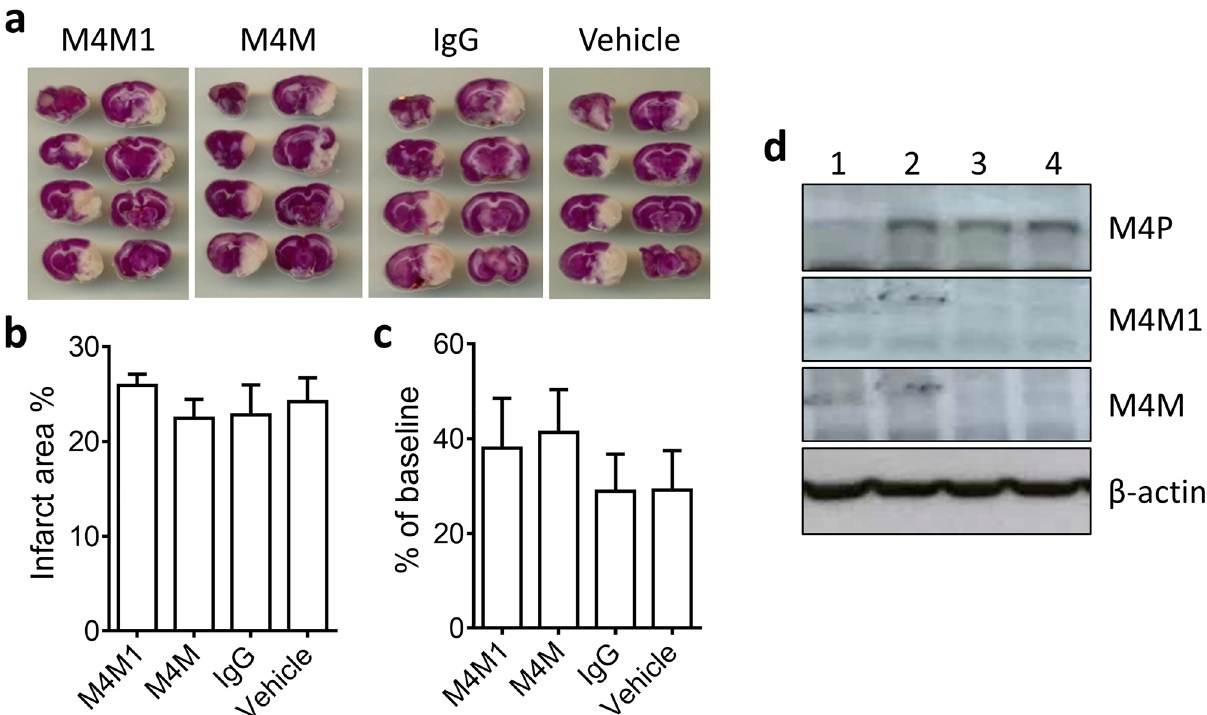
Figure 6. Both M4M and M4M1 failed to improve stroke outcome in wild type rats. ( a ) Transient stroke model was created by occluding left middle cerebral arteries for 3 h. Control mouse IgG, M4M1, M4M (each at 100 μg) and vehicle were injected 1 h before recanalization. TTC staining was performed 1 day after operation. ( b ) Summary of infarct area at 1 day after stroke. ( c ) Assessment of motor functions by Rotarod test 1 day after stroke induction. ( d ) Using western blot to detect TRPM4 expression within the ipsilateral hemispheres 1 day after stroke induction. Lane 1–4: sham operation, control mouse IgG, M4M1 and M4M. Full-length blots are presented in Supplementary Fig. S3. For ( a – d ), n = 8 rats per group. No significance was detected in ( b,c ) using one-way ANOVA with Bonferroni post-hoc